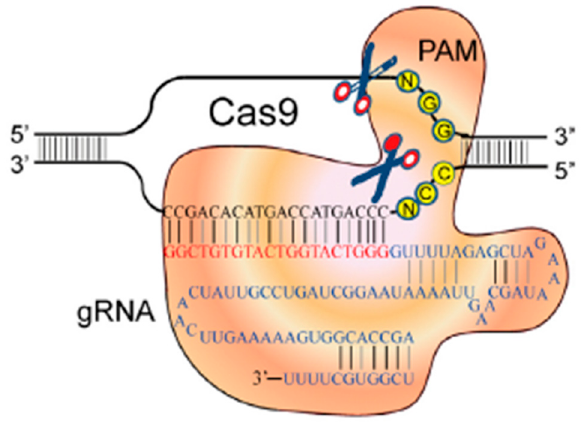
Figure 5. Genome editing with CRISPR/Cas9